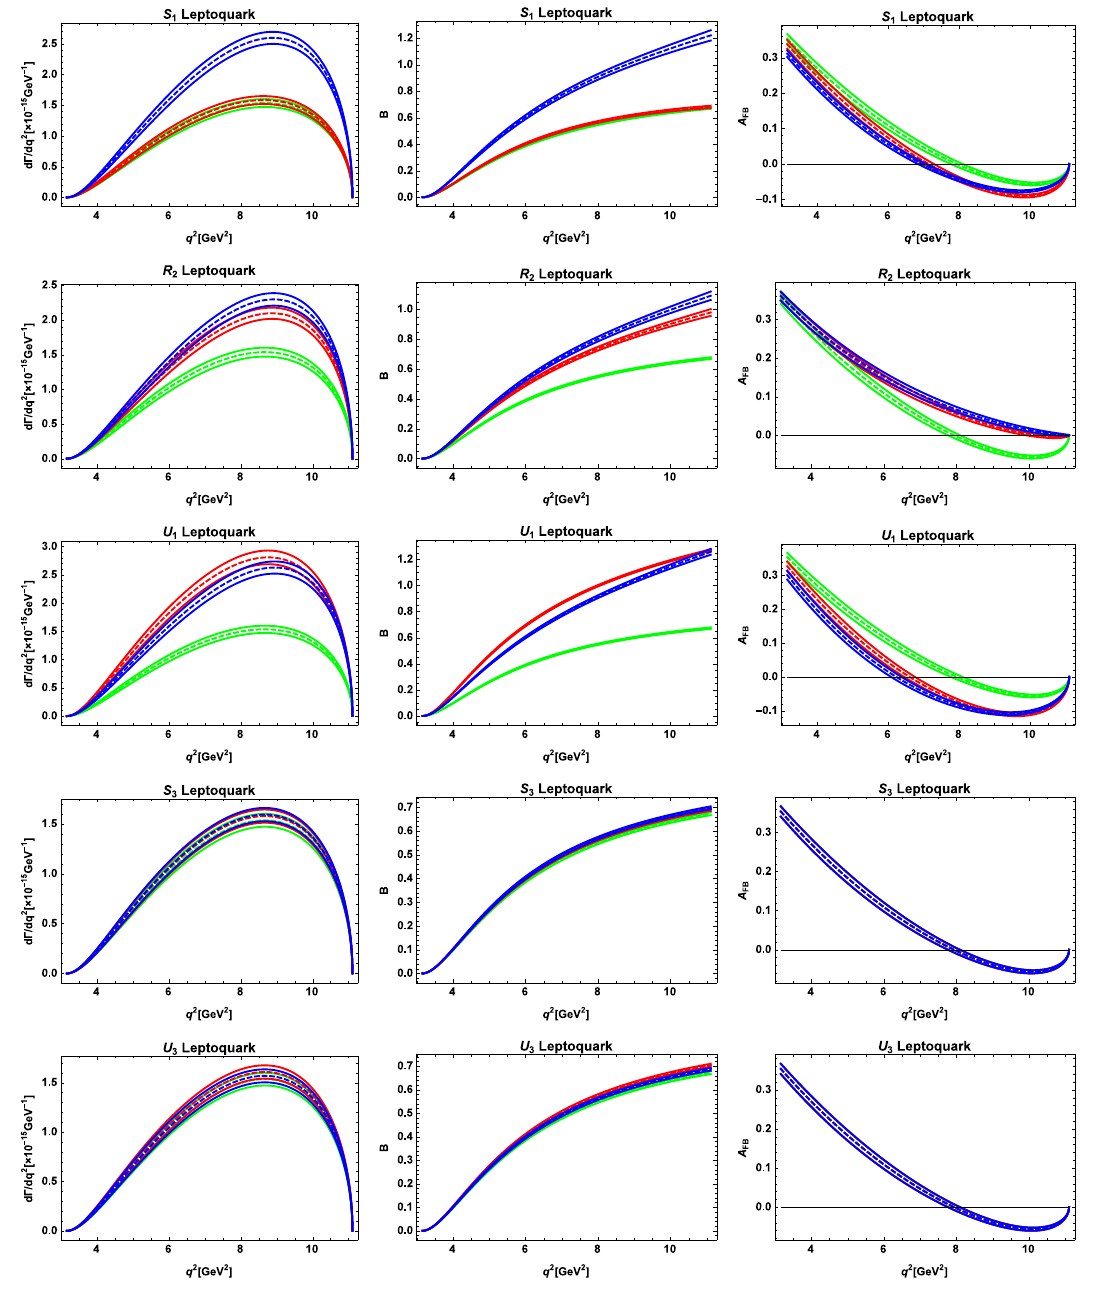
Figure 13 . The effects of the different leptoquark models on the Λ b Λ c τ ¯ ν τ differential decay → rate (left), the ratio of the Λ b Λ c τ ¯ ν τ and Λ b Λ c ℓ ¯ ν ℓ differential decay rates (middle), and the → → Λ b Λ c τ ¯ ν τ forward-backward asymmetry (right), for two representative choices of the couplings. → The red and blue curves correspond to the couplings from Cases 1 and 2 in table 6, respectively, while the green curves correspond to the Standard Model. Because the S 3 and U 3 leptoquarks produce only the vector coupling g L , the forward-backward asymmetry remains equal to the Standard Model in those cases. The bands indicate the 1 σ uncertainties originating from the Λ b Λ c form →